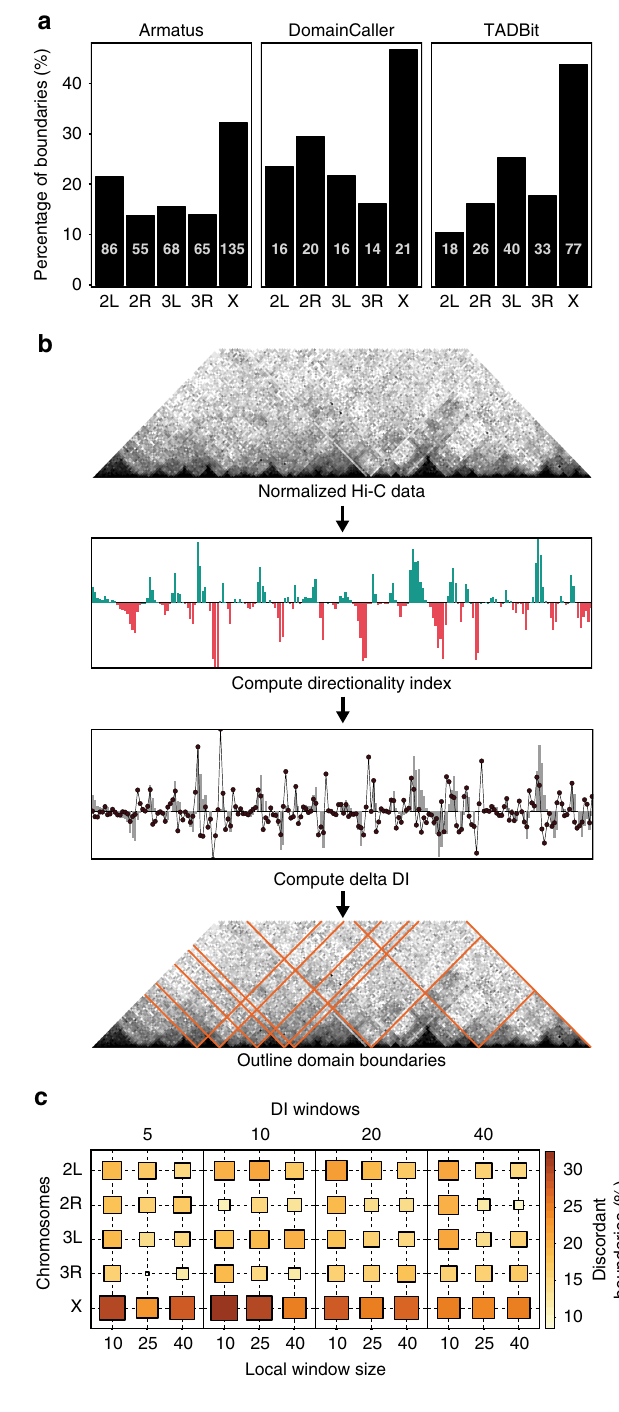
and able to handle high-resolution data matrices, we developed a structural domain boundary calling procedure named Local Score Differentiator (LSD). LSD is robust to copy number differences, fast in analysing high-resolution matrices, and stably maintains